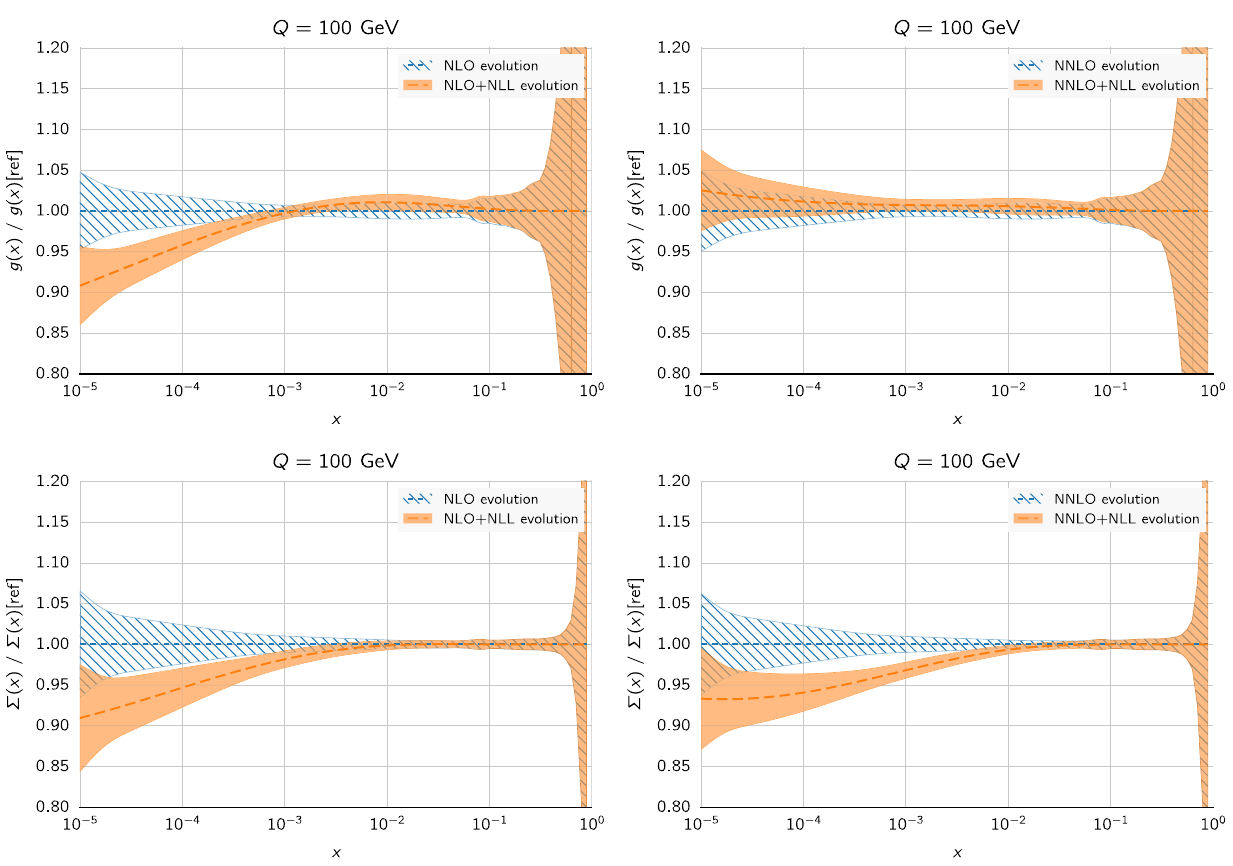
Fig. 2 The ratio of the gluon (upper plots) and quark singlet (lower plots) for the evolution from a fixed boundary condition at Q 0 = 1 . 65 GeV up to Q = 100 GeV using either fixed-order theory (NLO left,